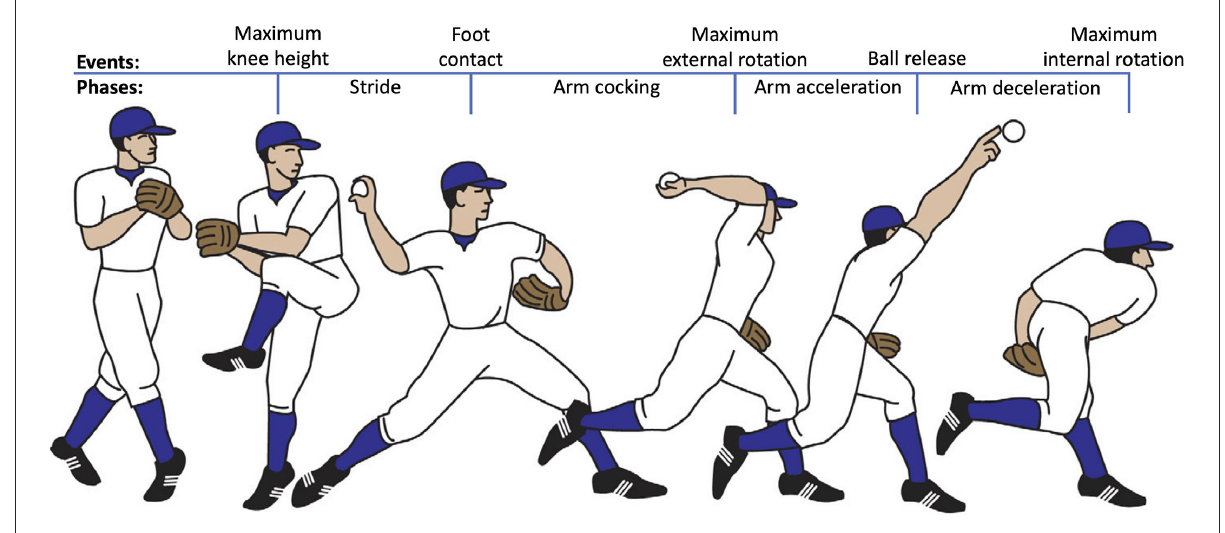
FIGURE1 Events and phases of the baseball pitch used in biomechanical analysis. Modified from Braun et al. (16).